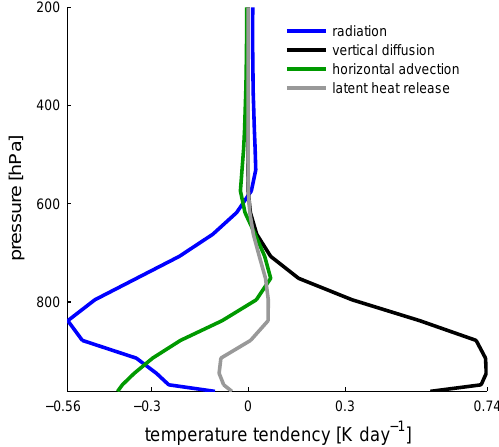
Fig. 5. Temperature tendencies for perpetual off-equatorial insola- tion in the region of maximum solar heating, between 15 and 30 ◦ N. Vertical advection of temperature is negligible because tempera- tures are close to the dry